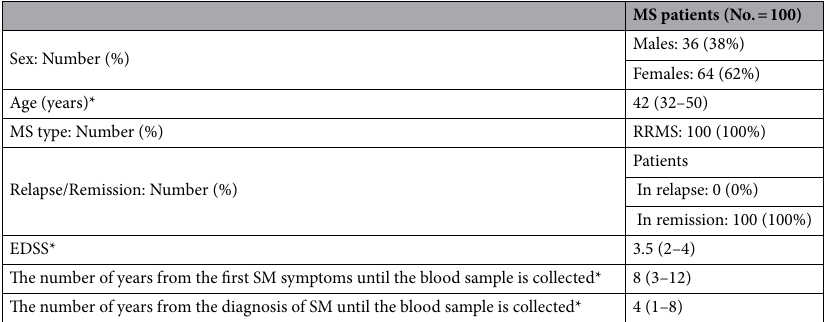
Table 1. Demographical and clinical data of MS patients. MS multiple sclerosis, RRMS relapsing–remitting multiple sclerosis, EDSS Kurtzke’s Expanded Disability Status Scale. * Data is presented as Median with 25th and 75th